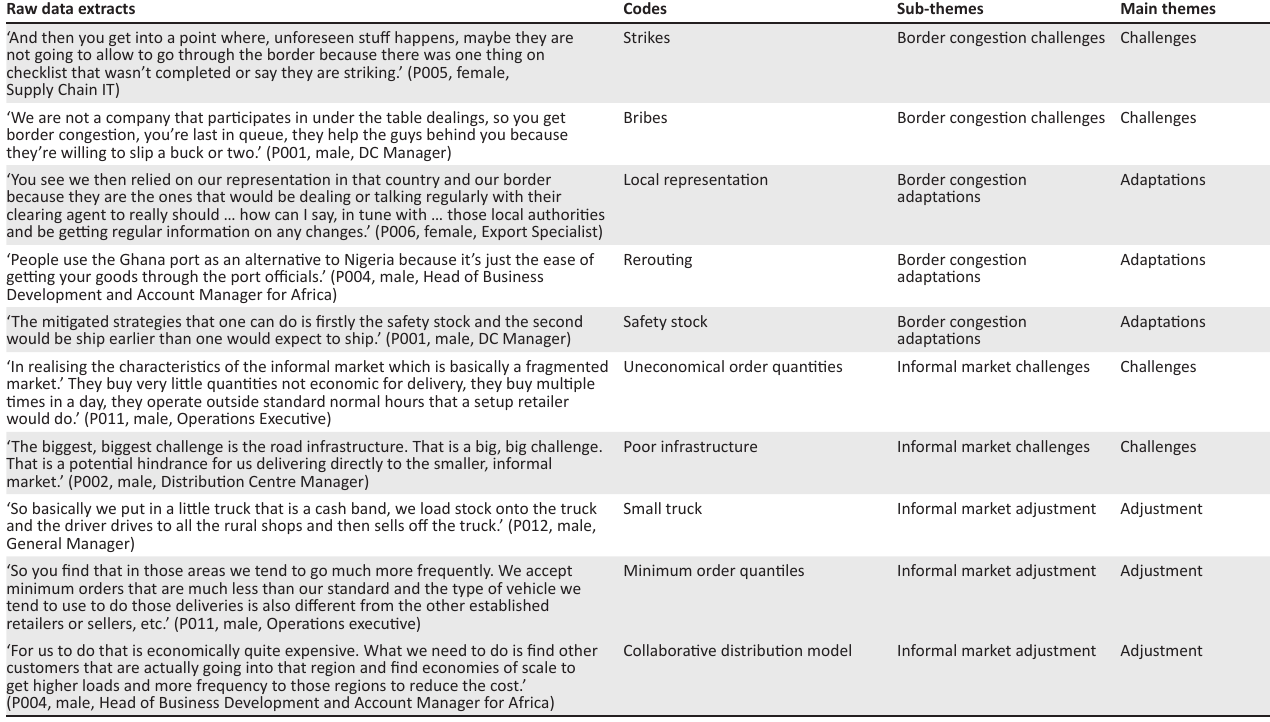
TABLE 1-A1 (Continues...): The link between the codes, sub-themes and main themes identified in this